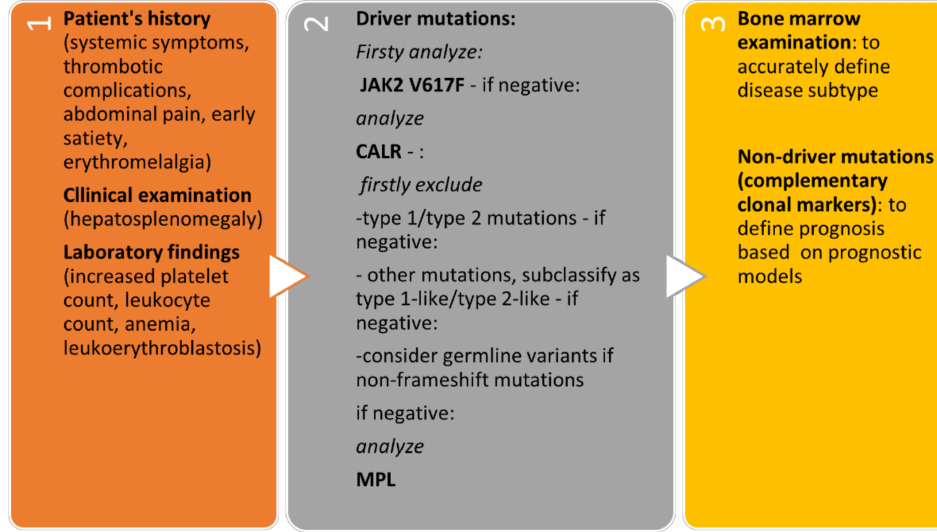
Figure 3. Algorithmic approach to patients with suspected CALR -positive